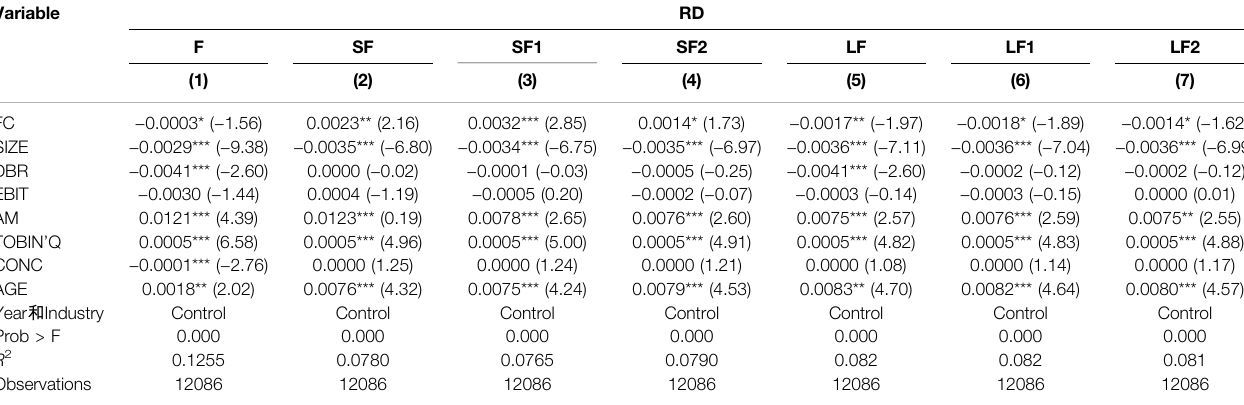
TABLE 10 | Regression results of the relationship between fi nancialization and R&D expenditure of fi rms.